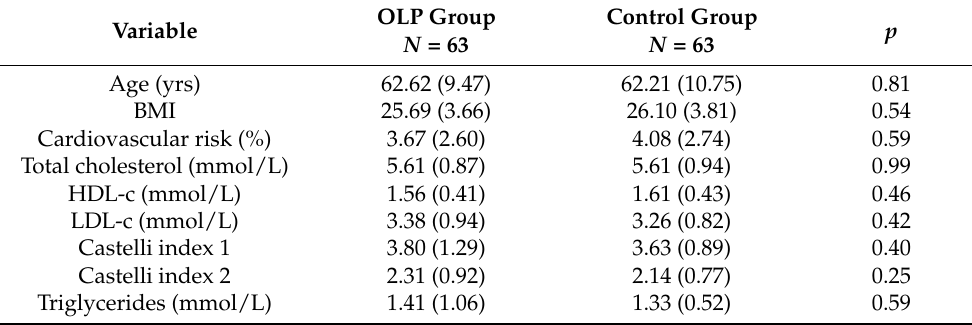
Table 1. Statistically basic parameters of age, body mass index (BMI), calculated cardiovascular risk, cholesterol and triglycerides level, and calculated Castelli indexes in OLP and control group. Variable